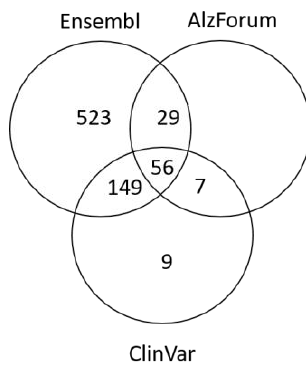
Figure 8. Common variations in three of the selected genotype-phenotype